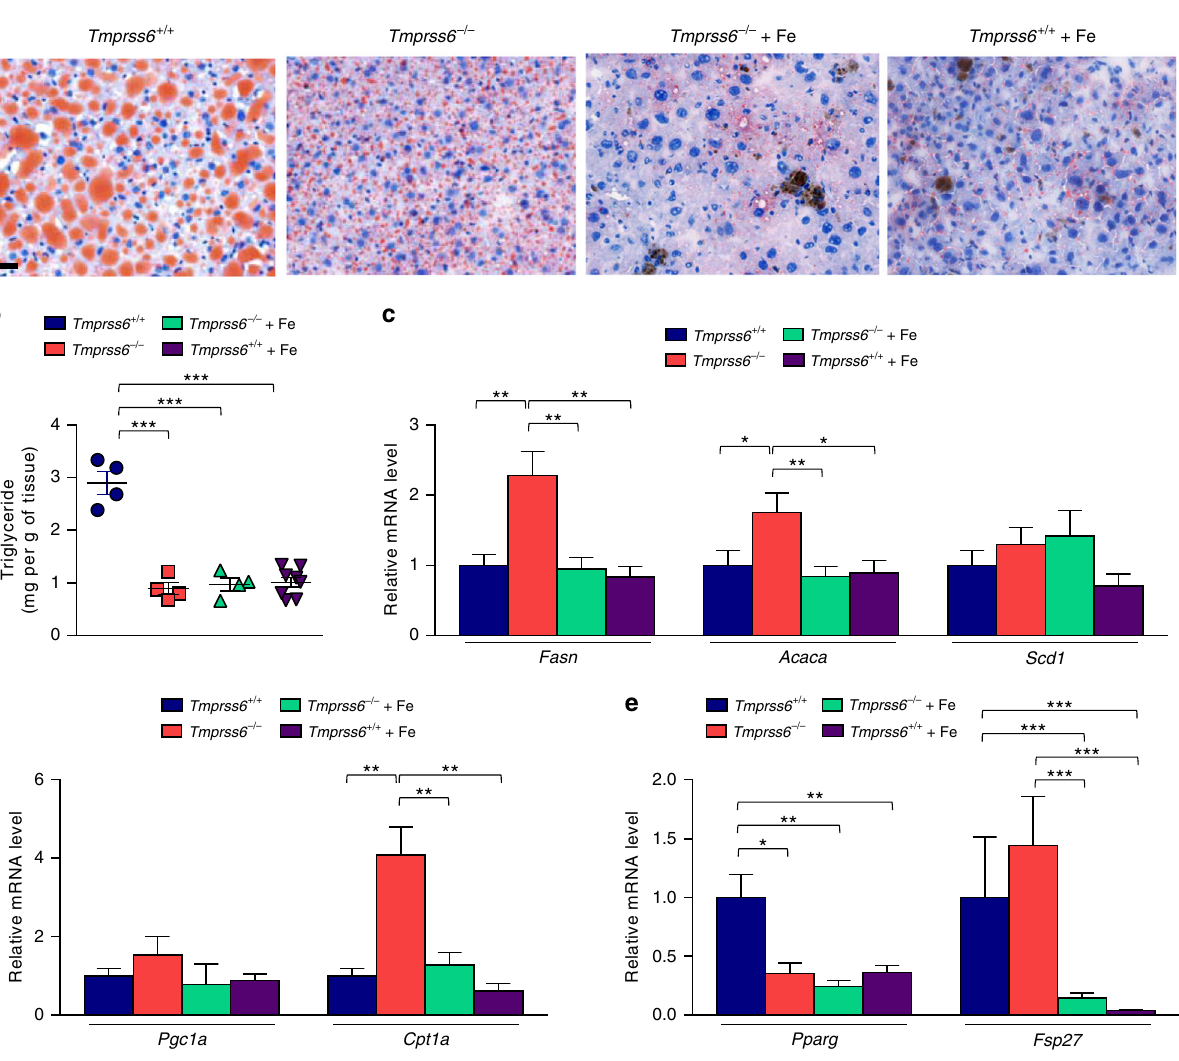
Fig. 3 Matriptase-2 loss impairs hepatic steatosis upon HFD feeding. a Representative Oil Red O staining of liver sections from Tmprss6 + / + ( n = 4), Tmprss6 − / − ( n = 4), and both iron-treated Tmprss6 − / − and Tmprss6 + / + mice ( n = 4 and n = 8, respectively) fed a HFD. b Triglyceride content of liver samples from HFD-fed Tmprss6 + / + ( n = 4), Tmprss6 − / − ( n = 4), and both iron-treated Tmprss6 − / − and Tmprss6 + / + mice ( n = 4 and n = 8, respectively). Relative expression levels of genes related to lipogenesis ( c ), β -oxidation ( d ), and lipid storage ( e ) in liver samples from HFD-fed Tmprss6 + / + ( n = 11), Tmprss6 − / − ( n = 8 – 10), and both iron-treated Tmprss6 − / − and Tmprss6 + / + mice ( n = 9-10 and n = 7 – 8 respectively). Scale bar = 20 µ m. Data shown are mean ± SEM. * P < 0.05, ** P < 0.01, *** P < 0.001, two-tailed Student ’ s t test and Mann –